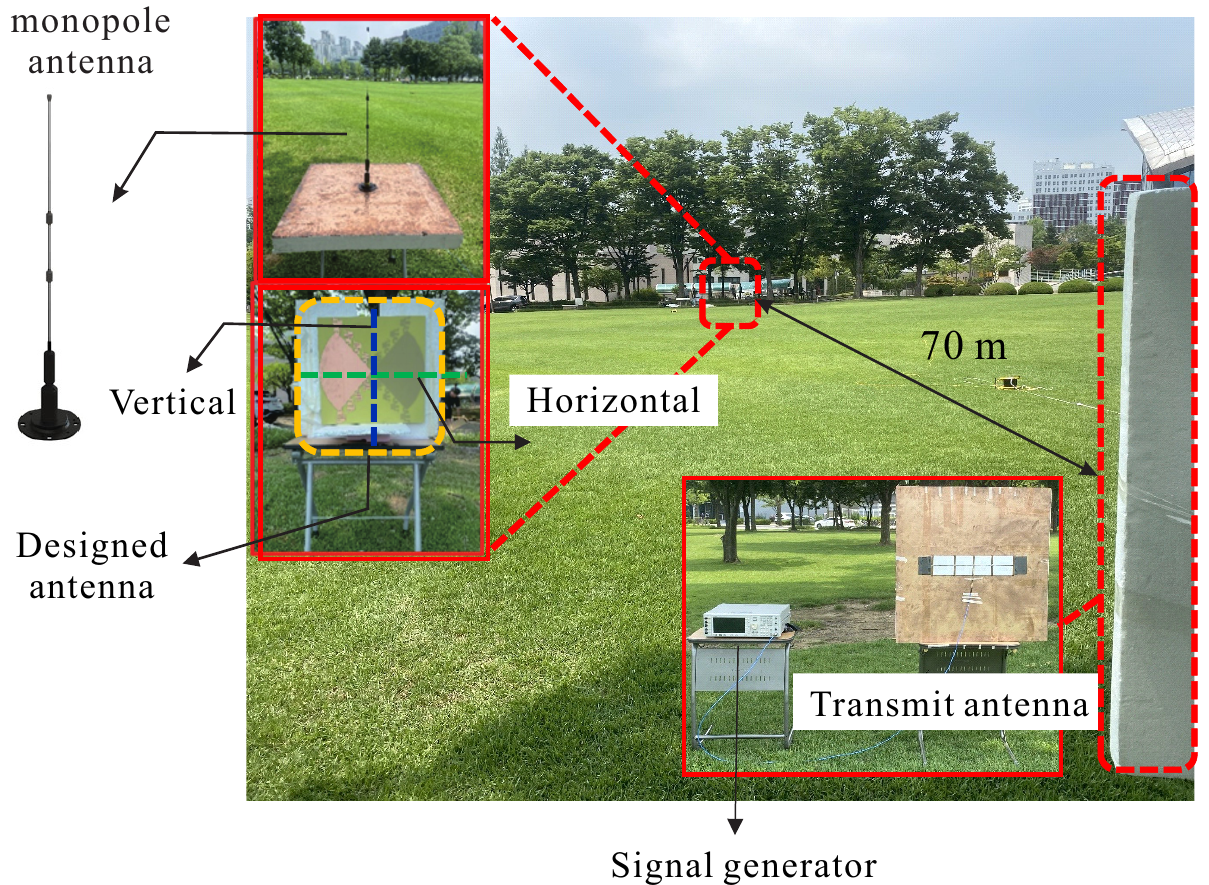
Figure 11. Received power measurement